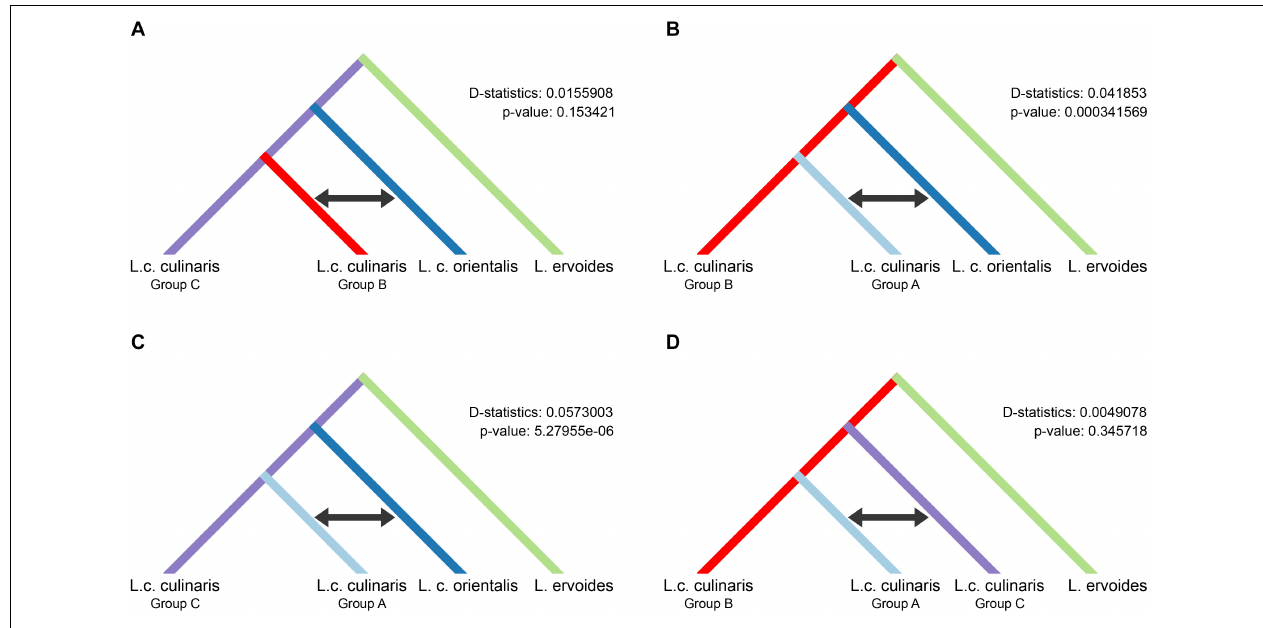
FIGURE 4 | Results of the four-taxon ABBA-BABA test used to detect introgression between wild orientalis and groups of culinaris (A–C) and between culinaris groups (D) . Groups were defined in the STRUCTURE K = 4 model. The black arrow indicates the groups between which gene flow is detected.